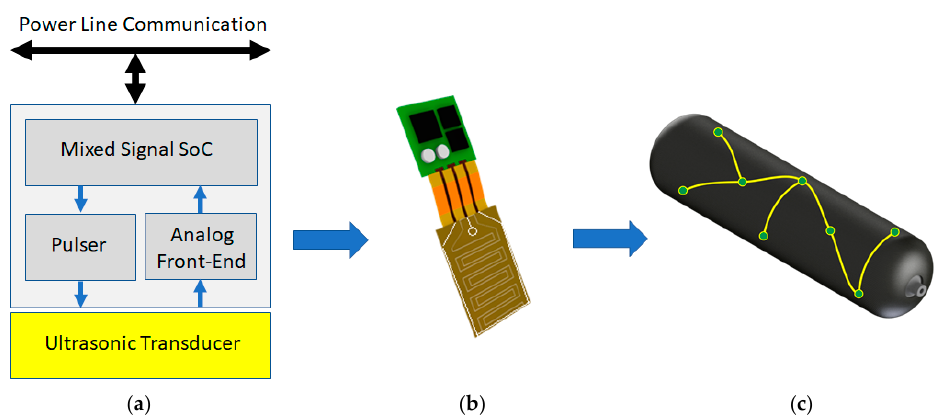
Figure 10. A wired sensor network based on autonomous sensor node design. In the example each node is equipped with ab ultrasonic transducer for active and passive ultrasonic guided waves (UGW) operation: ( a ) node electronic block scheme; ( b ) node rendering; and, ( c ) rendering of a possible application to a Composite Overwrapped Pressure Vessel (COPV) equipped with a wired sensor network.